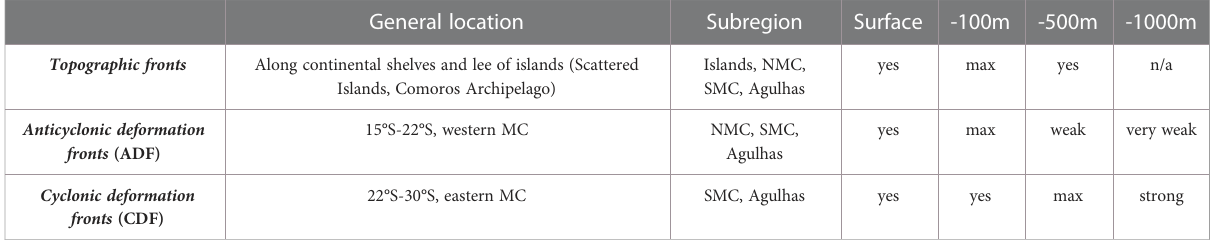
TABLE 1 Front typology based on behavior and depth